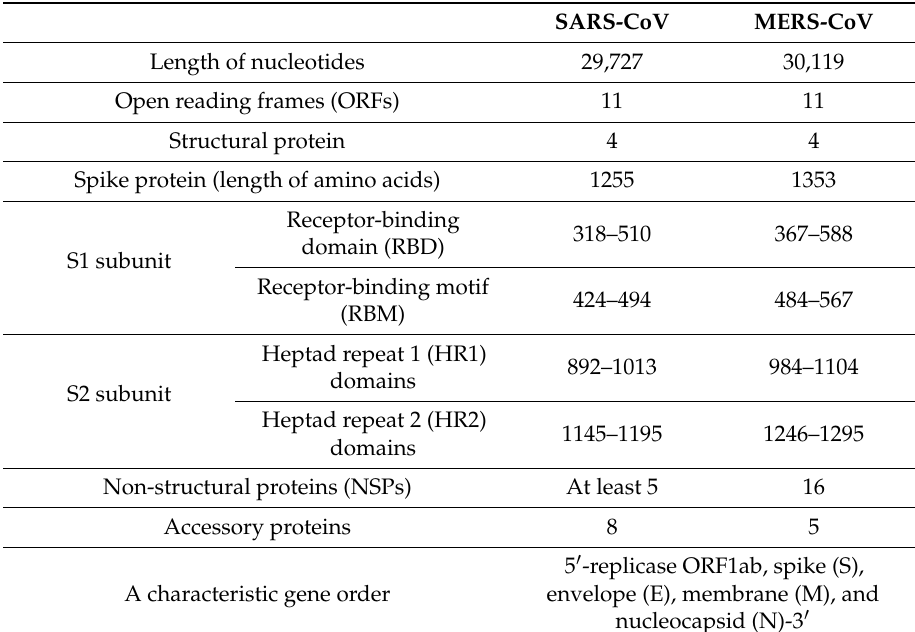
Table 2. The genomic characterization of SARS-CoV and